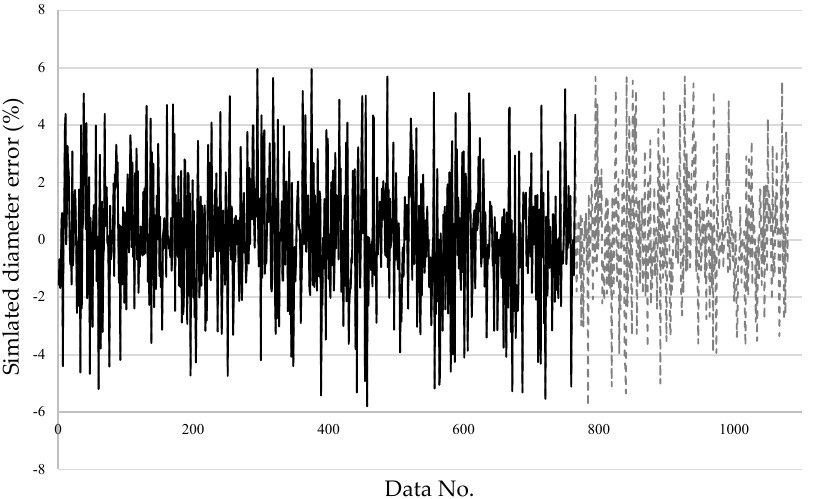
Figure 11. The SLDM-simulated diameter R O percentage error.